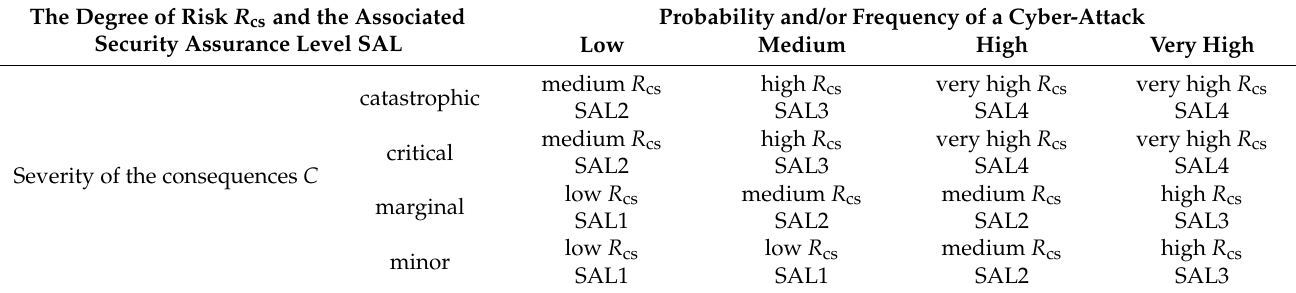
Table 5. Risk Matrix Regarding Cybersecurity Issues at the Critical Infrastructure Facility.